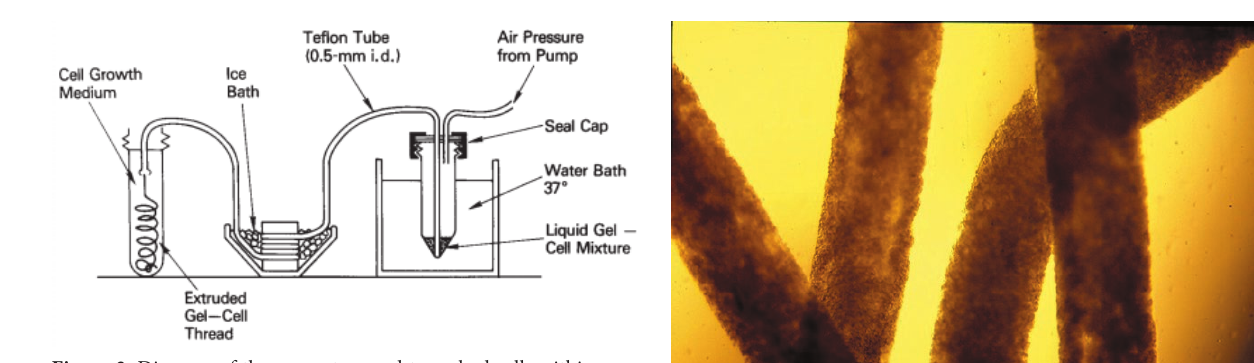
Figure 3. Diagram of the apparatus used to embed cells within aga- rose gel threads. A mixture of cells in medium is extruded through a fine Teflon capillary in chilled ice. The gel thread is then extruded directly into medium in the 10-mm screw-cap NMR tube. 41